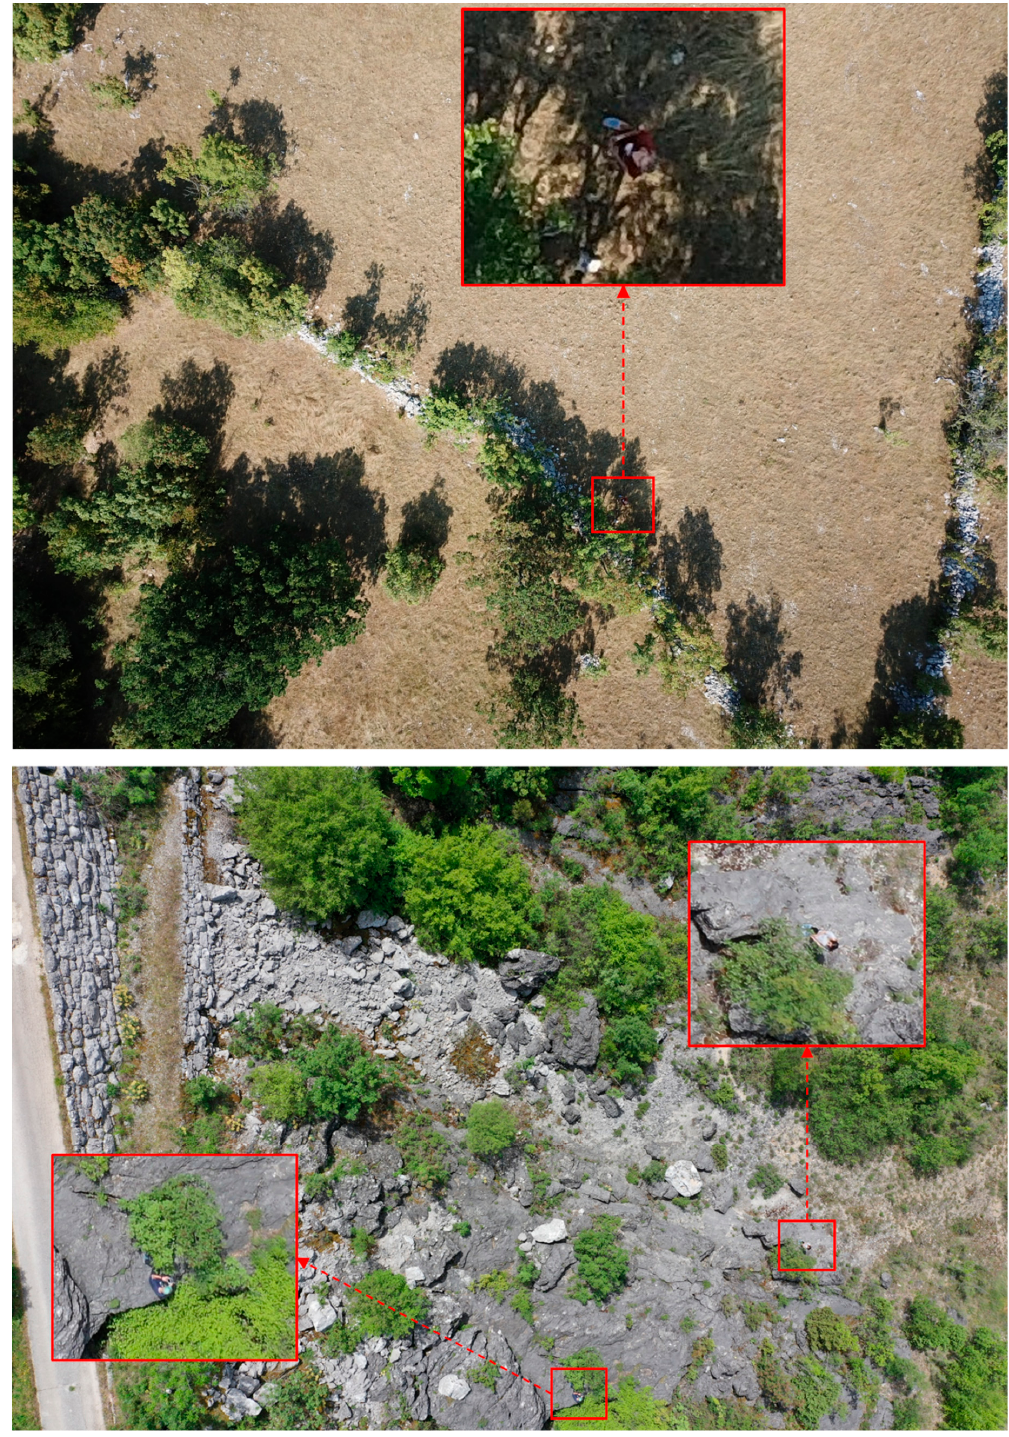
Figure 1. An example of the complexity of aerial images and enlarged parts of where people are located.